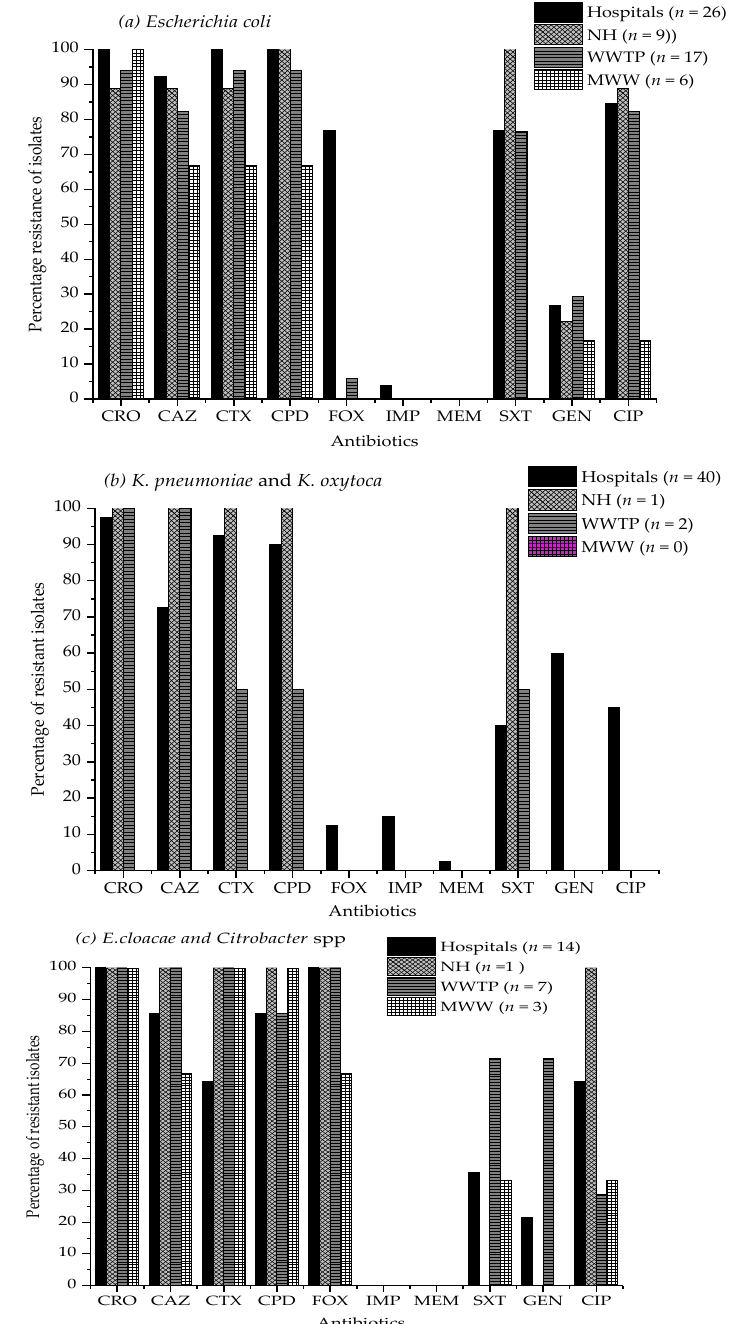
Figure 1. Antimicrobial resistance percentage of ( a ) E. coli , ( b ) Klebsiella pneumoniae, and K. oxytoca , ( c ) Enterobacter cloacae , and Citrobacter species isolates from four hospital effluents, nursing home, wastewater treatment plant, and municipal wastewater to ten different antibiotics. CRO, ceftriaxone; CAZ, ceftazidime; CTX, cefotaxime; CPD, cefpodoxime; FOX, cefoxitin; IPM, imipenem; MEM, meropenem; SXT, sulfamethoxazole/trimethoprim; GEN, gentamicin; CIP, ciprofloxacin. Study sites: NH, nursing home; WWTP, wastewater treatment plant; MWW, municipal wastewater. The absence of a bar indicates that no resistance was observed.